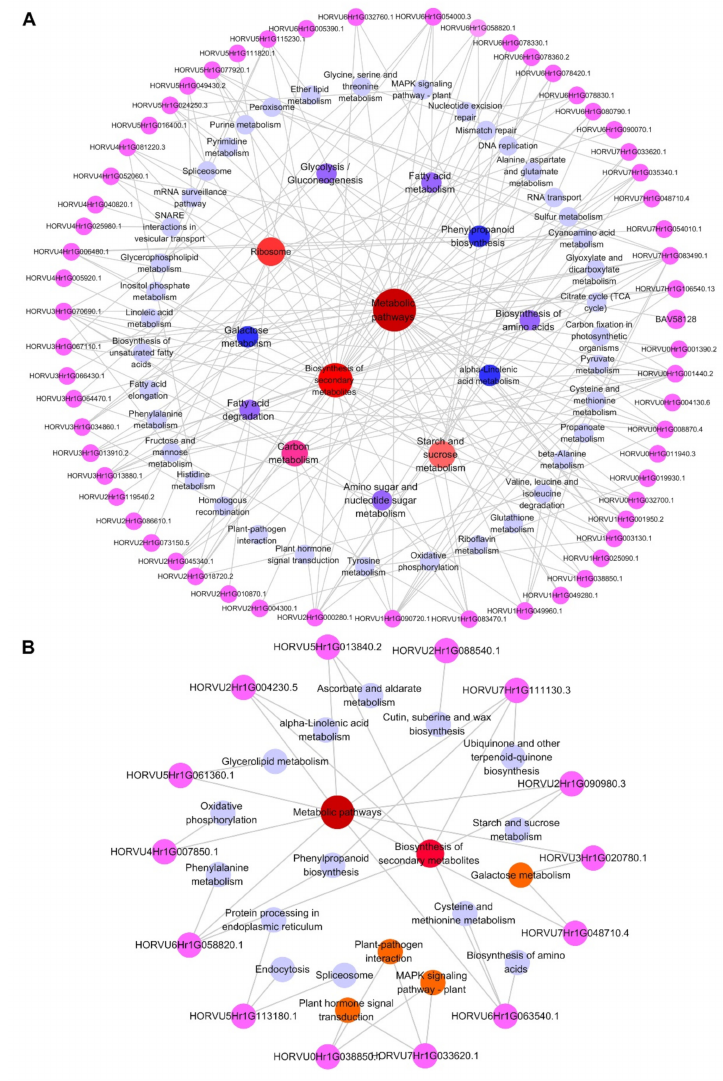
Figure 8. A summary of the partially critical DEPs related to the response of GN2 ( A ) and GN18 ( B ) seeds to salt stress and the KEGG pathways involved. All proteins are represented by a pink circle, and the KEGG pathways are represented by circles of different colors. The color shade and circle size are positively correlated with the number of proteins contained in the circle, with the least amount of protein contained in purple circles and the most amount of protein contained in red